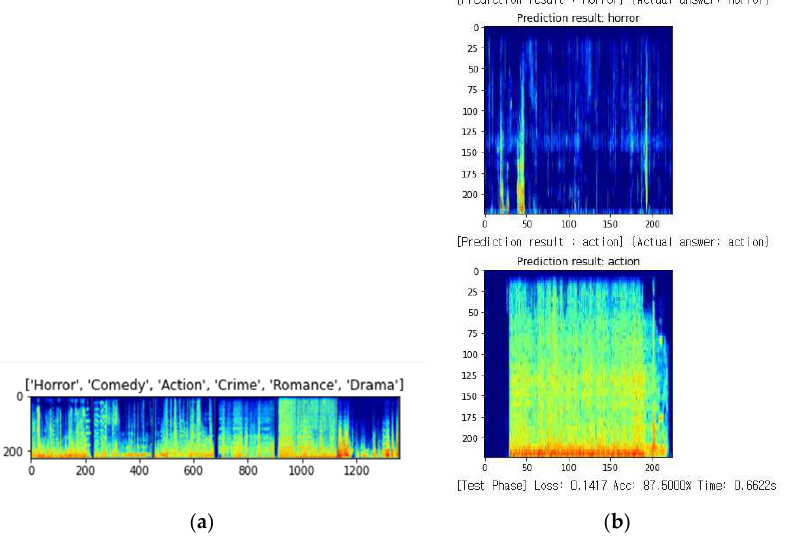
Figure 6. Spectrogram image learning result for genre recognition: ( a ) is training data placement results by genre and ( b ) is test data prediction and evaluation results.